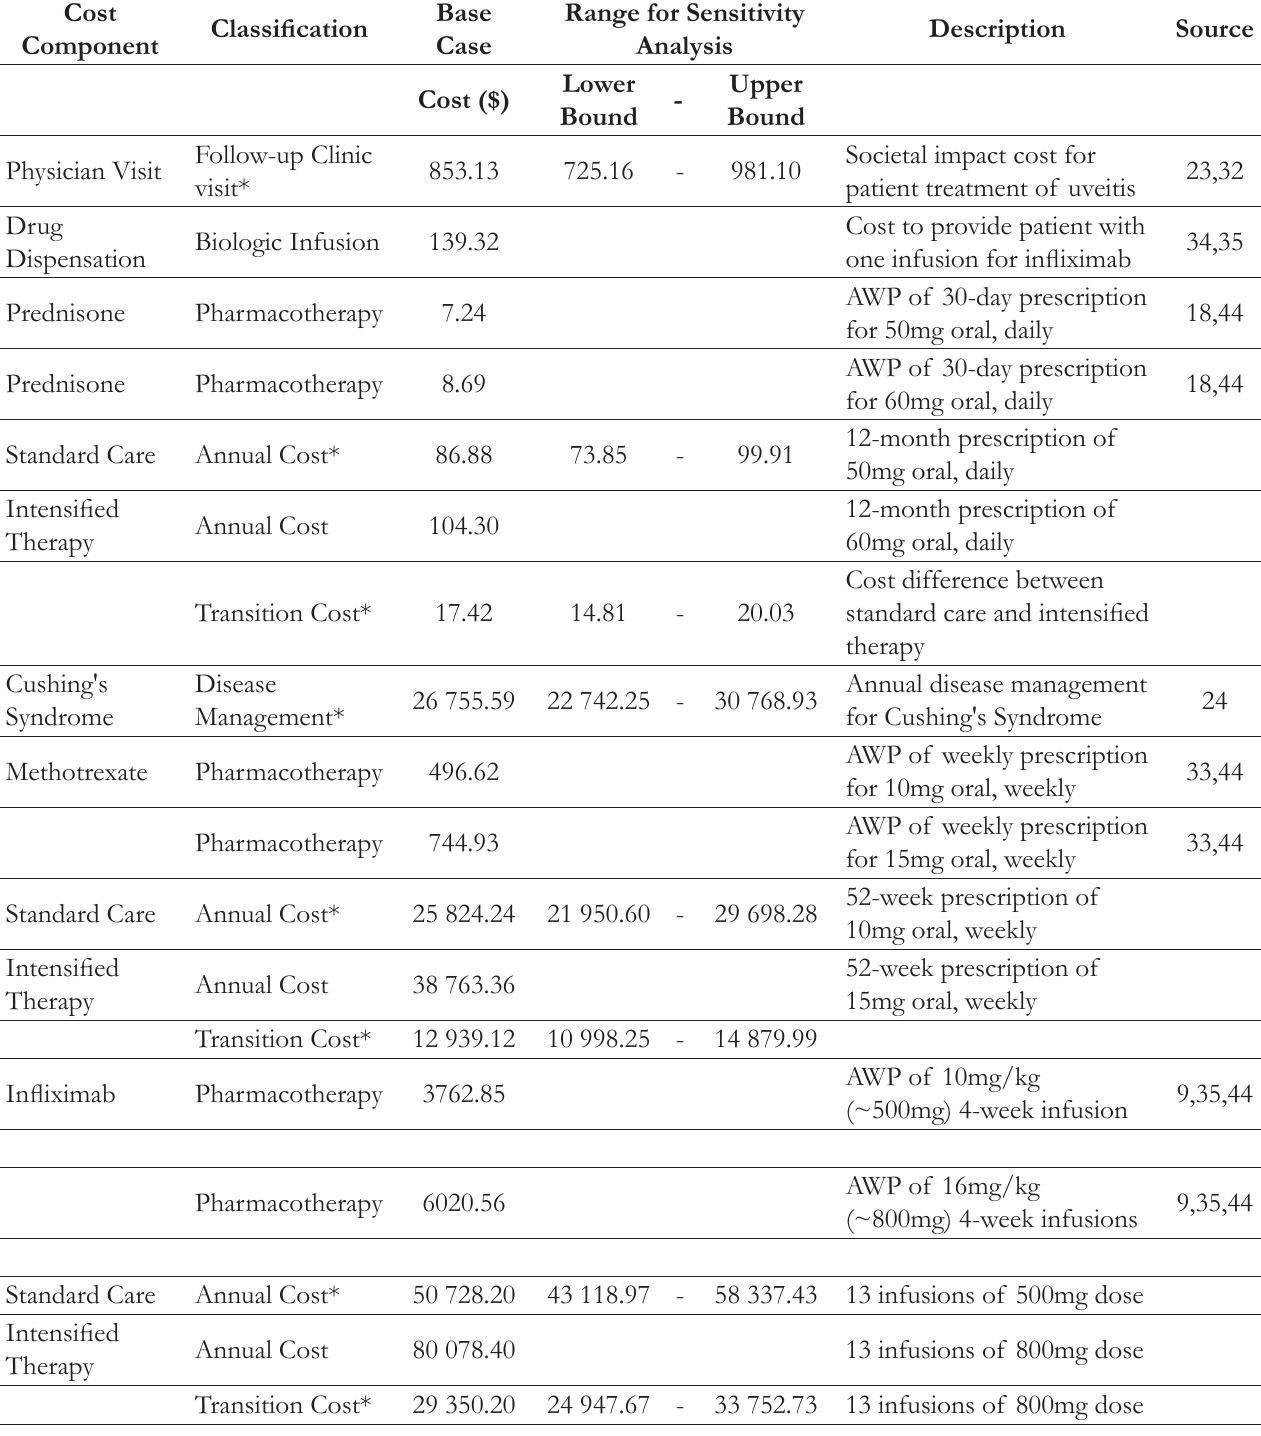
Table 1a. Parameters of the Posterior uveitis and panuveitis Markov Care Model: Annual Resource Costs ($US, 2010